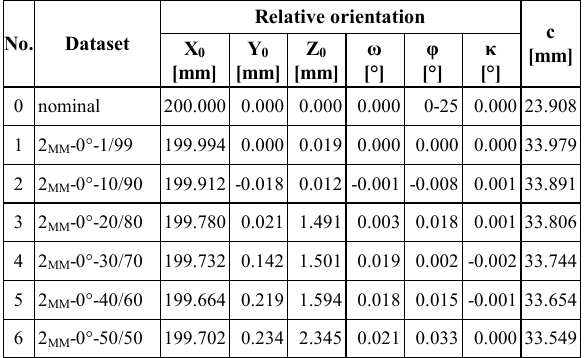
Table 3. Relative orientation and principal distance as a result of the bundle adjustment using standard software for different datasets with varying air to water